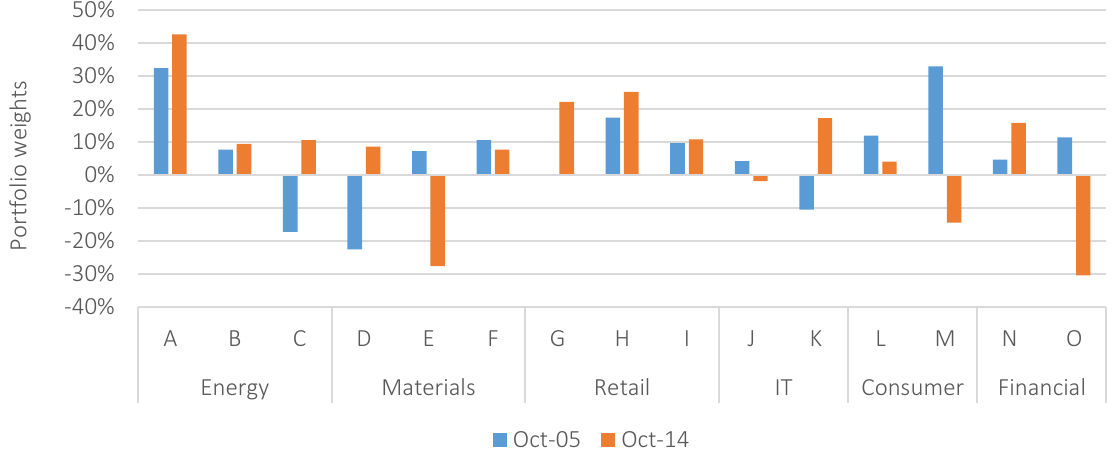
Figure 5. Weights in optimal, unconstrained Ω portfolios for Oct-00 – Oct-05 and Oct-09 –